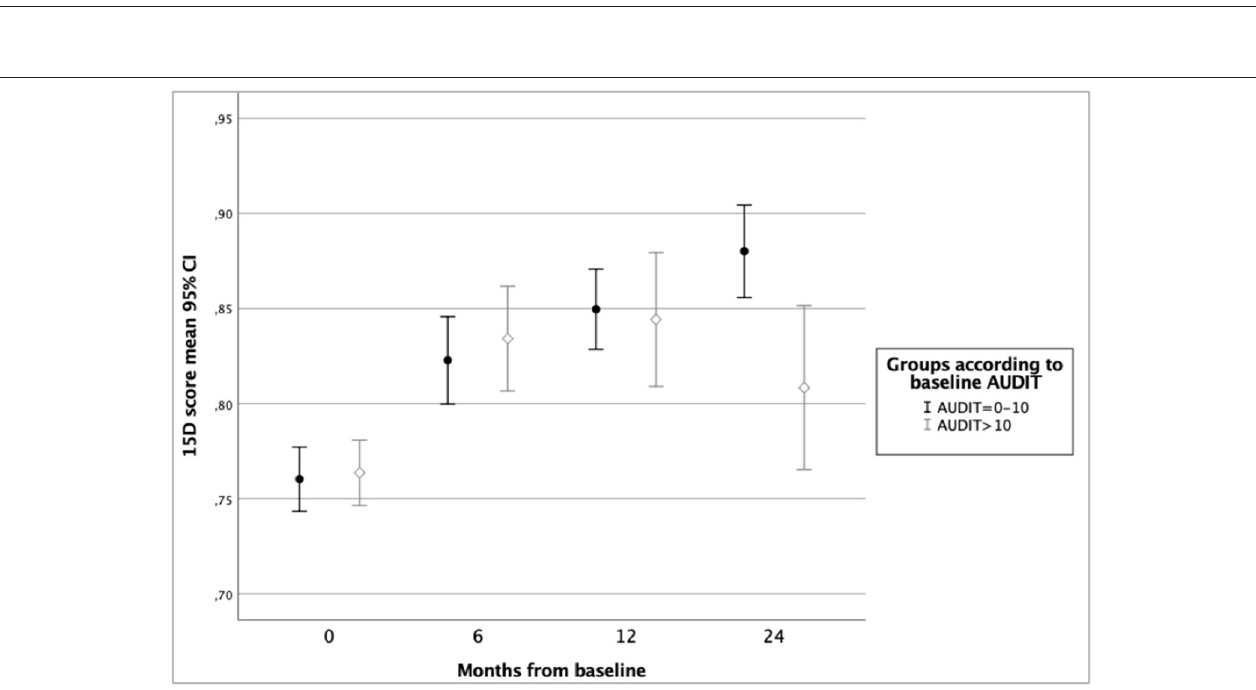
FIGURE 2 | Health-related quality of life of ODS study patients according to 15D score and baseline Alcohol Use Disorders Identification Test (AUDIT) score.